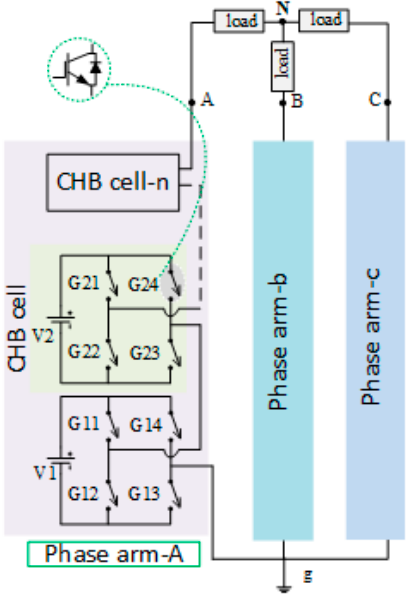
Figure 3. Conventional three-phase CHB-MLI. Reprint with permission [4261051118814]; 2018, IEEE.